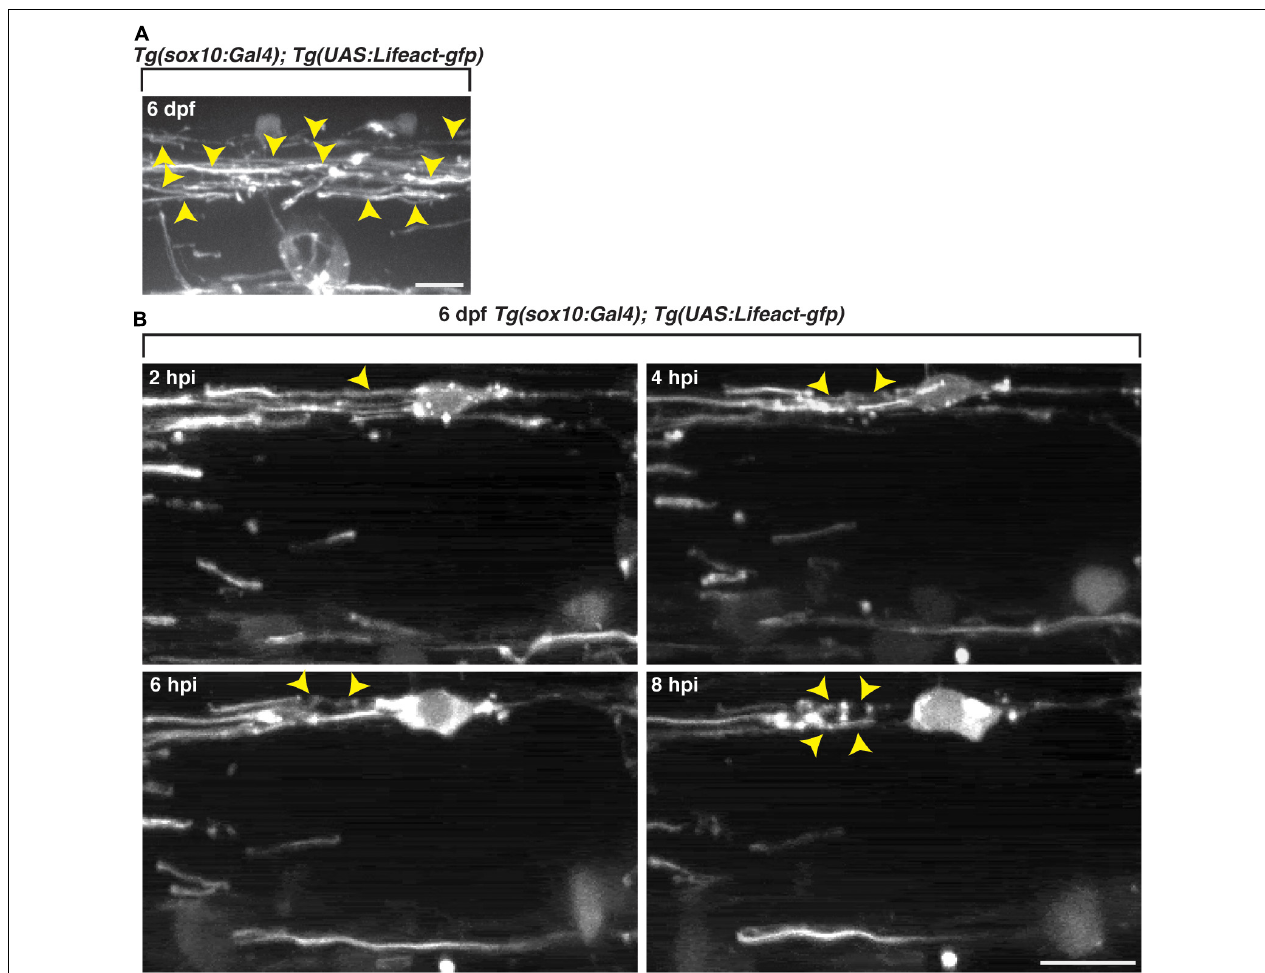
FIGURE 7 | Oligodendrocyte cytoskeletal components dynamically change following exposure to lysolecithin. All images are lateral views of the spinal cord with anterior to the left and dorsal to the top. (A) In vivo imaging of Tg ( sox10:Gal4; UAS:Lifeact-gfp ) larvae at 6 dpf. Arrowheads denote the actin in sheath formation. (B) Following injection of lysolecithin into a 6 dpf Tg ( sox10:Gal4; UAS-Lifeact-gfp ) zebrafish, in vivo time-lapse imaging reveals that GFP + F-actin dynamically changes from a sheath-like arrangement (2 hpi) to forming ovoid-like structures (8 hpi). Arrowheads identify the GFP + F-actin changes in a sox10 + cell. Scale bars, 25 µ